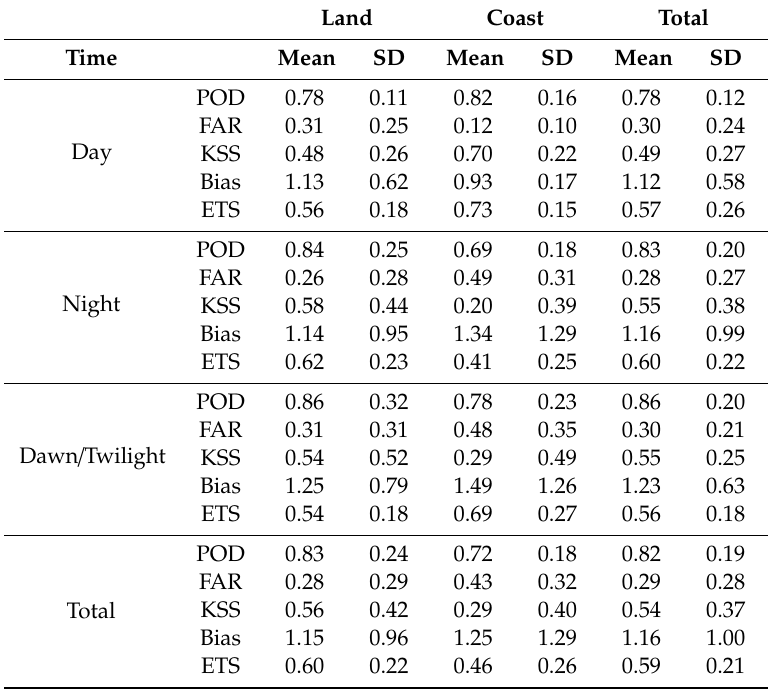
Table 6. Same as Table 5 except for validation